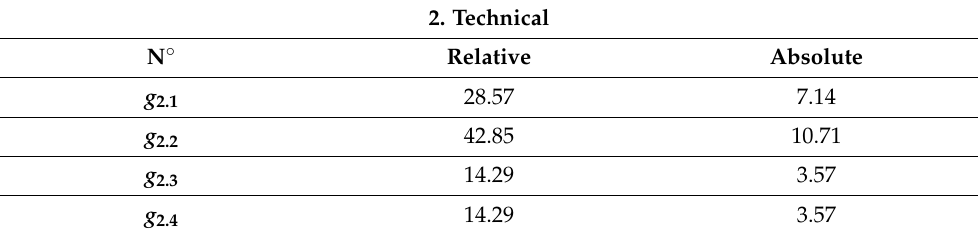
Table 7. Weighting of the technical criteria.